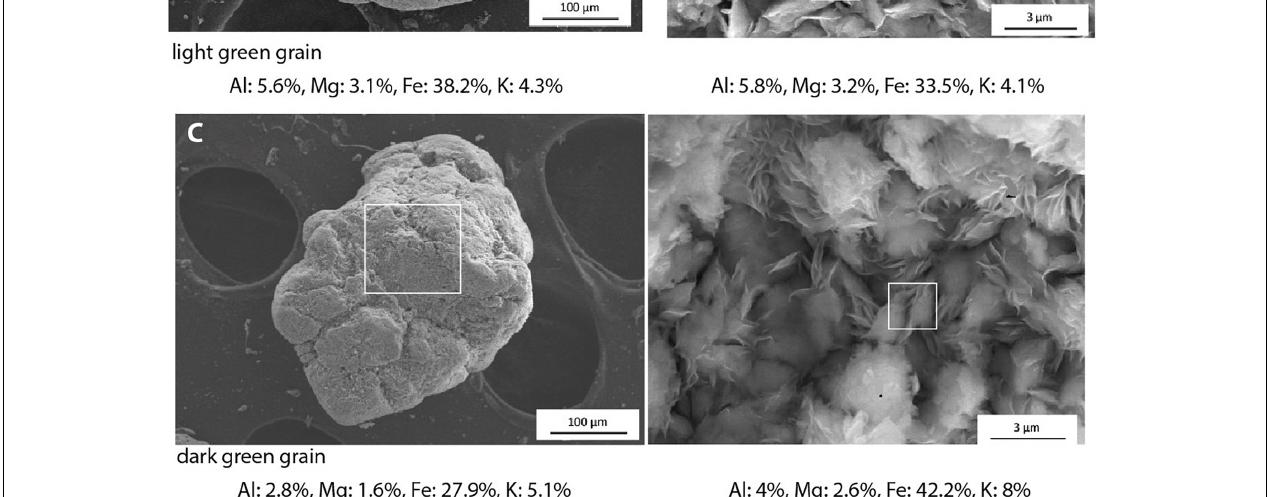
Frontiers in Earth Science |